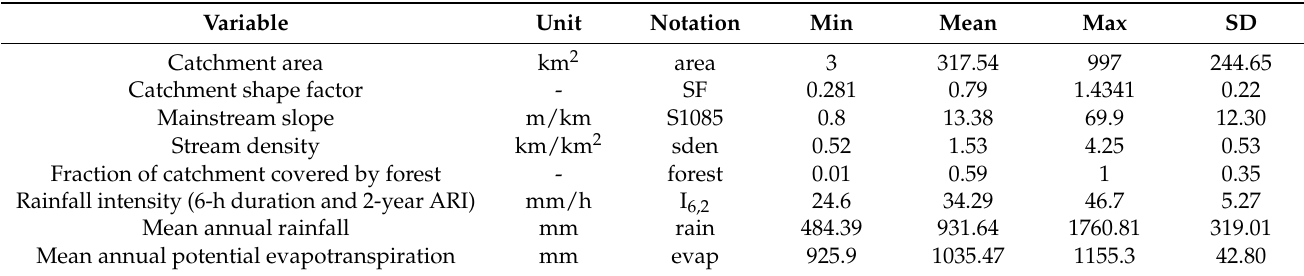
Table 1. Summary of catchment characteristics